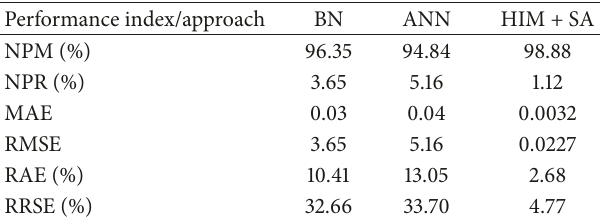
Table 5: Comparative study of the three models (ANN, BN, HIM +